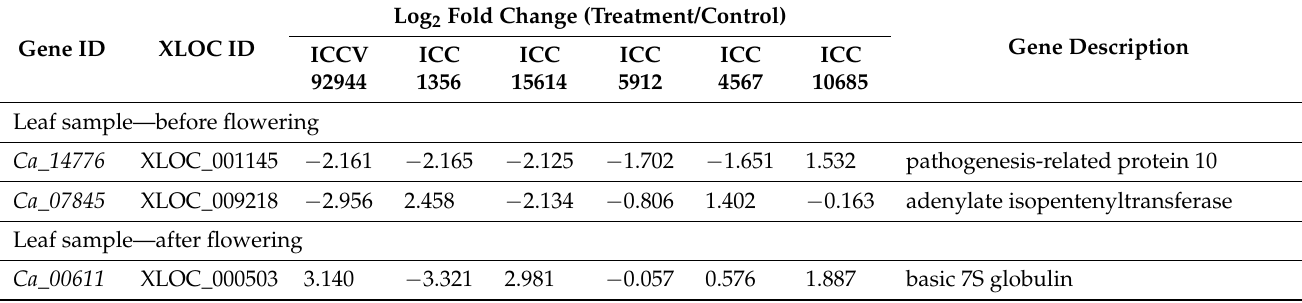
Table 2. Genes that exhibit significant differential expression in the tolerant genotypes but are not significantly regulated in the sensitive